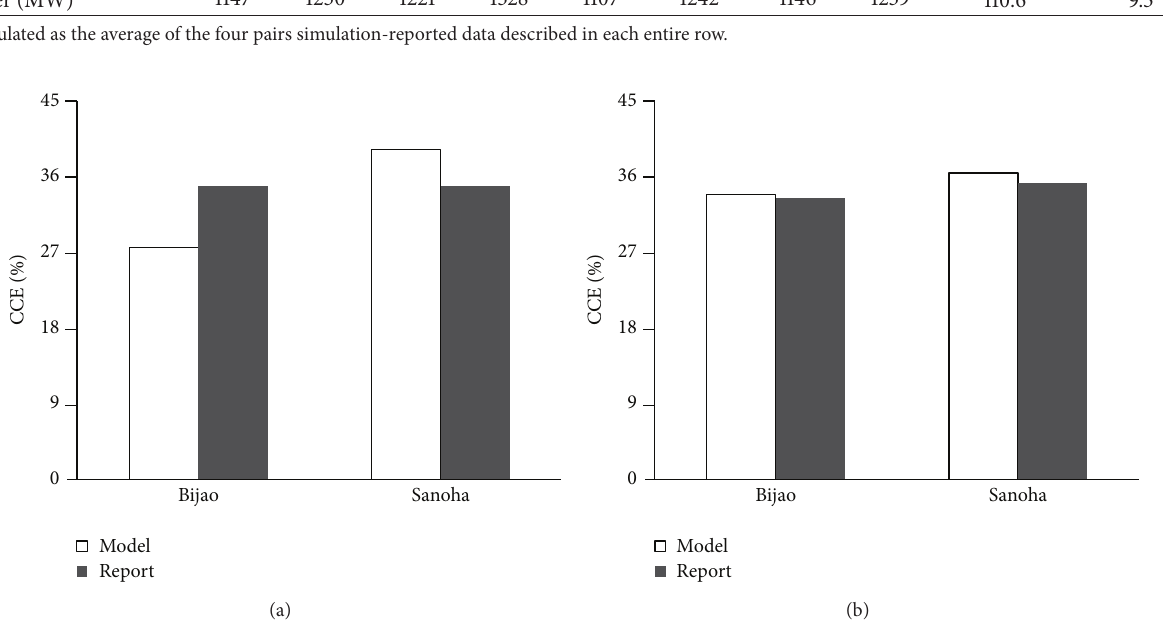
Figure 10: Carbon conversion efficiency (kg CH 4 /kg coal). Comparison for simulated and reported data for two Colombian coals; (a) slurry feeding technology and (b) dry feeding